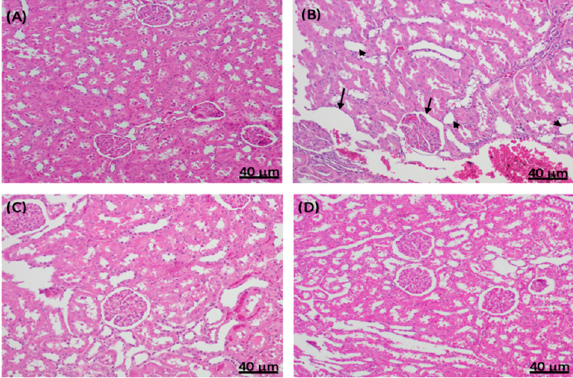
Figure 7. Effect of sitagliptin on STZ-induced pathological changes in rat kidney sections stained with hematoxylin and eosin. Representative images of kidney sections in ( A ) normal control rats with a normal histological appearance of renal corpuscles and tubules; ( B ) diabetic STZ control rats with increased thickening of the basement membrane (black arrows), necrosis (arrowheads), and diffuse interstitial inflammation and hemorrhage; ( C ) non-diabetic normal rats treated with sitagliptin (100 mg/kg/day, p.o.) with a normal basement membrane of the renal corpuscles; and ( D ) diabetic STZ rats treated with sitagliptin (100 mg/kg/day, p.o.), showing the alleviation of the STZ-induced damage.